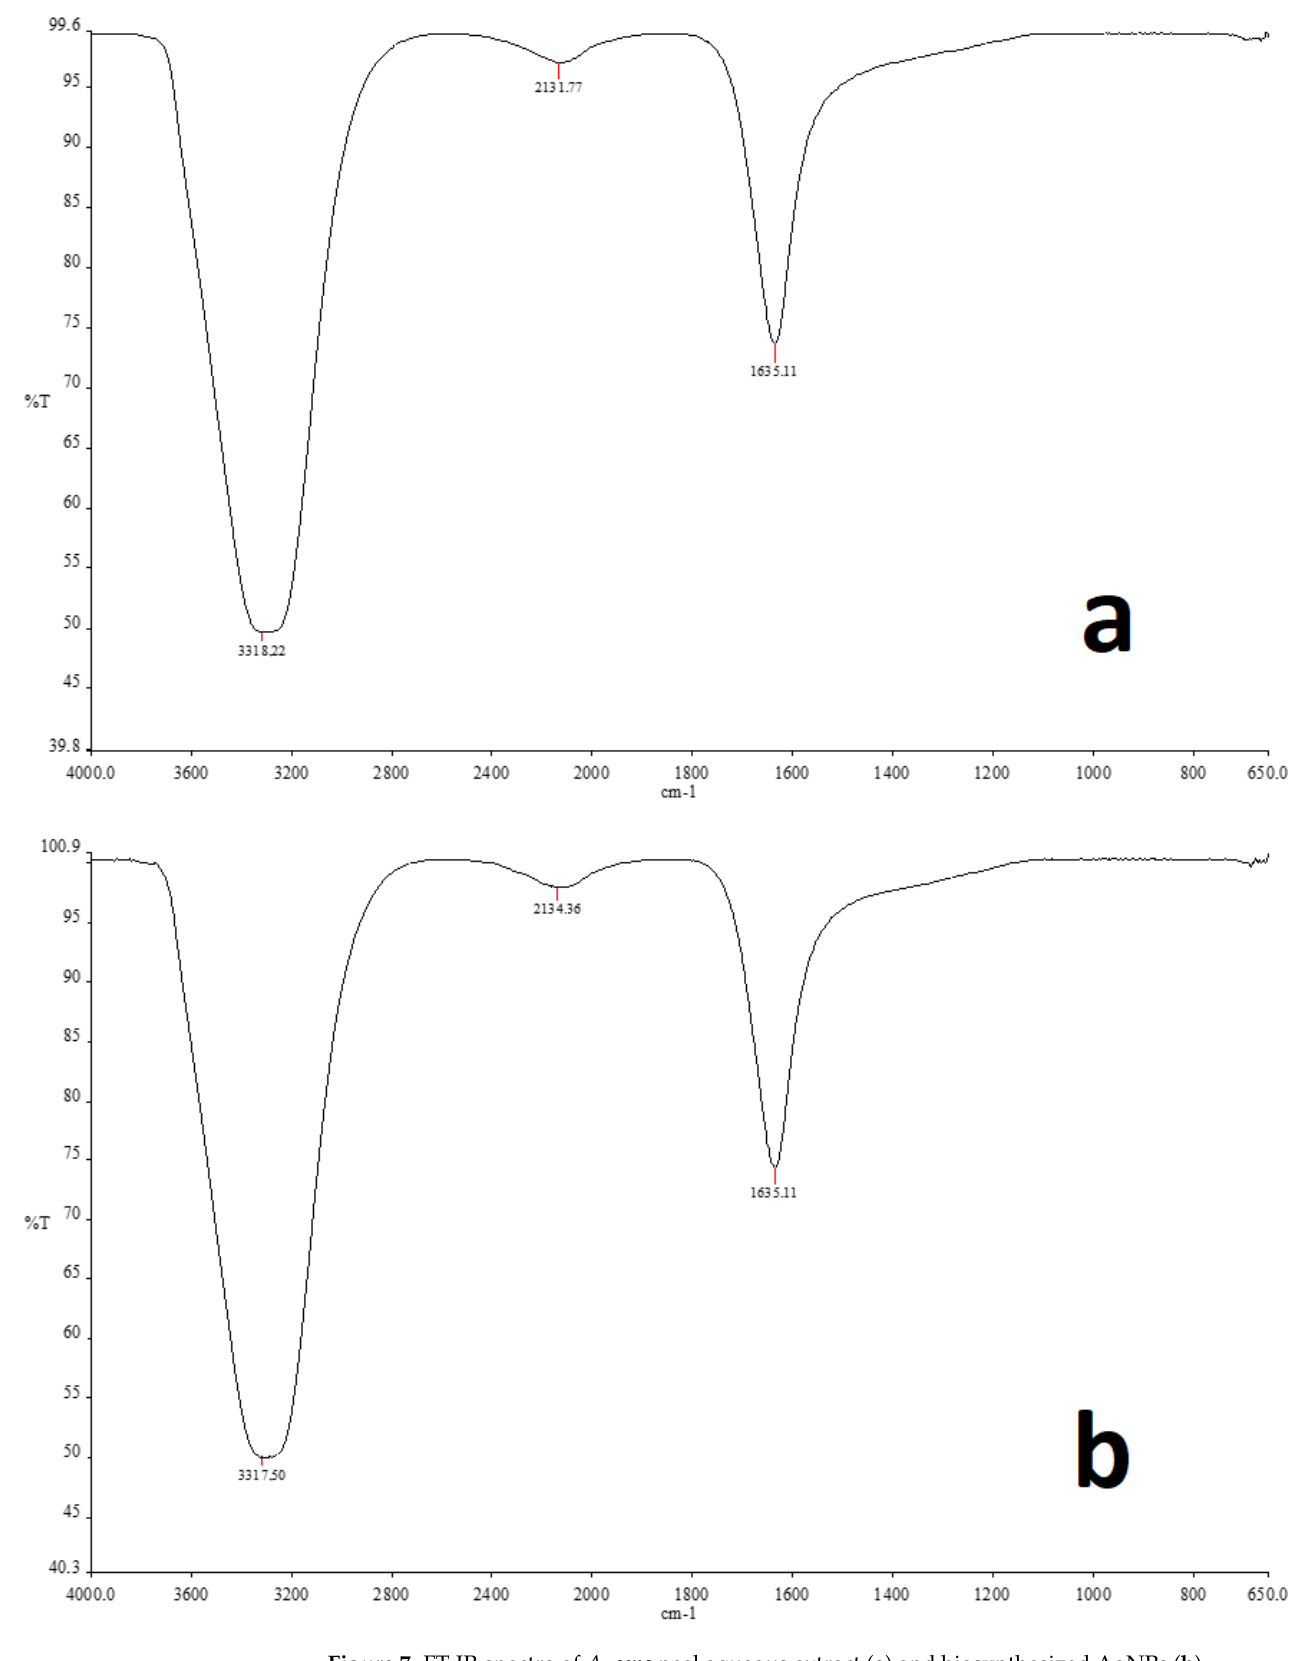
Figure 7. FT-IR spectra of A. cepa peel aqueous extract ( a ) and biosynthesized AgNPs ( b ).